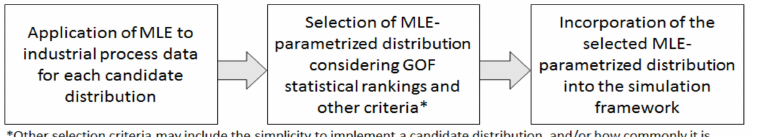
Figure 4. Data-driven representation of process variable distributions within a DES/DRS framework, using maximum likelihood estimation and goodness-of-fit